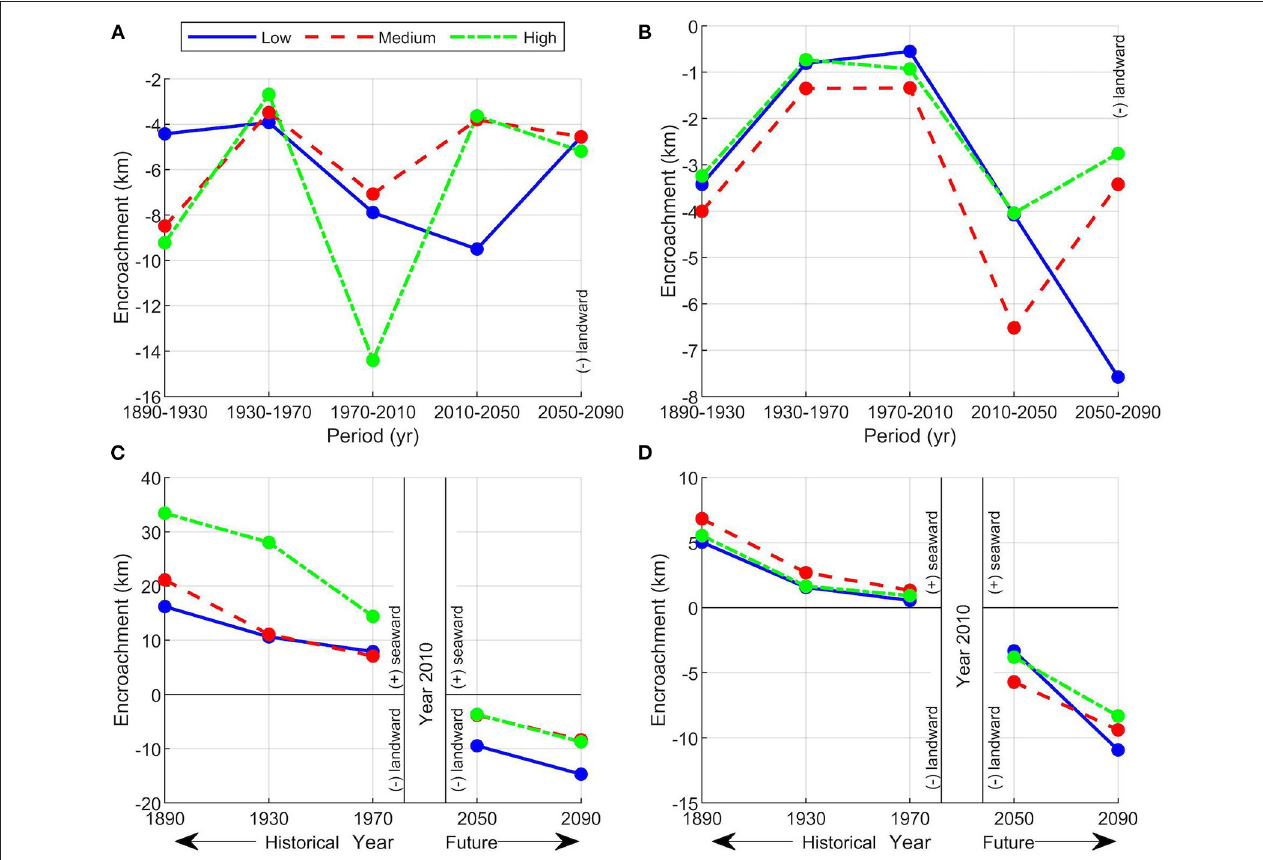
FIGURE 9 | Coastal flood zone encroachment between (A,B) successive eras, and between (C,D) a given era and the 2010 base condition at the (A,C) Barataria and (B,D) Lake Maurepas watershed for different flood magnitudes. The blue, red, and green lines represent low, medium, and high flood events, respectively. Positive values represent that the coastal flood zone for a given era has moved toward the ocean compared (A,B) to the previous era or (C,D) to the 2010 base conditions. Negative values represent that the coastal flood zone for a given era has moved inland compared (A,B) to the previous era or (C,D) to the 2010 base